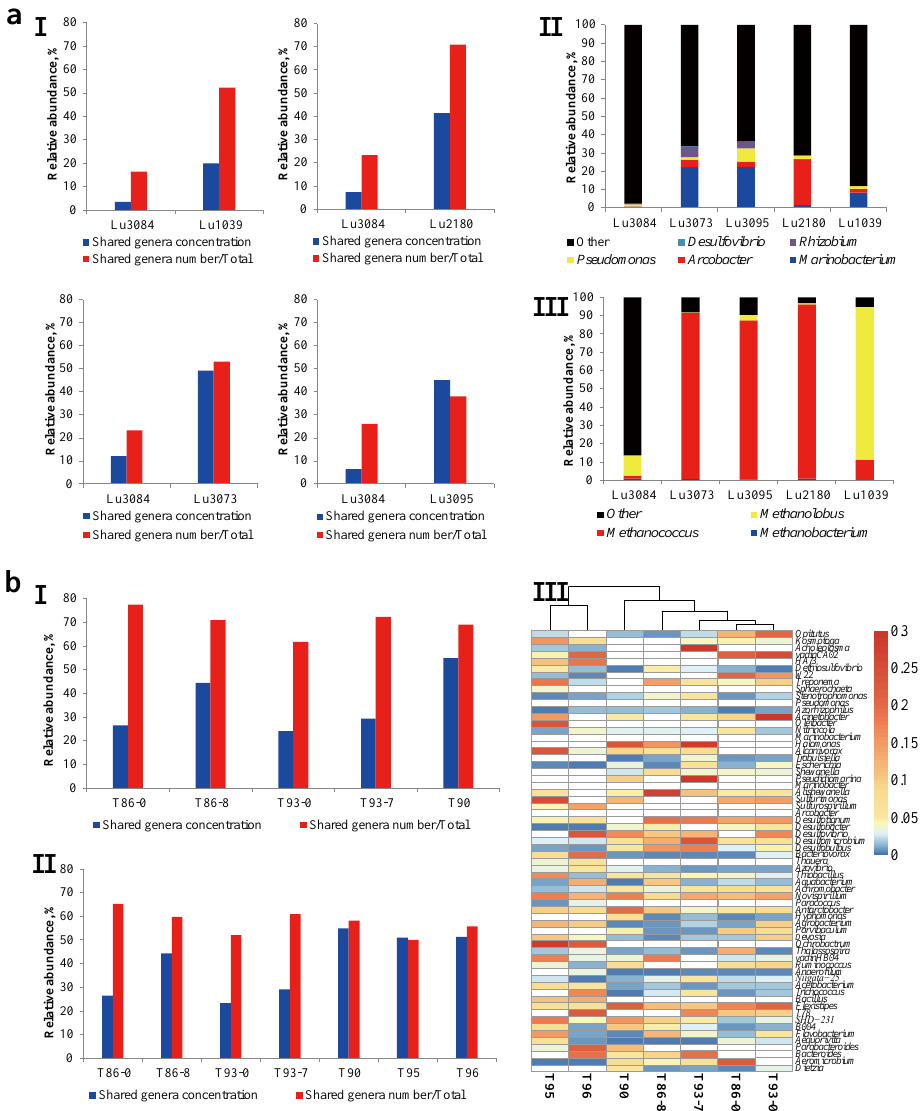
Figure 4. Comparison of shared microbial genera between the injection and production wells. (aI) Pairwise comparison between injection and production wells in the sandstone reservoir; (aII) shared bacterial genera in the injection and production wells; (aIII) shared archaeal genera in the injection and production wells; (bI) and (bII) comparison between injection and production wells on the conglomerate reservoir; and (bIII) dominant shared bacterial genera in the conglomerate